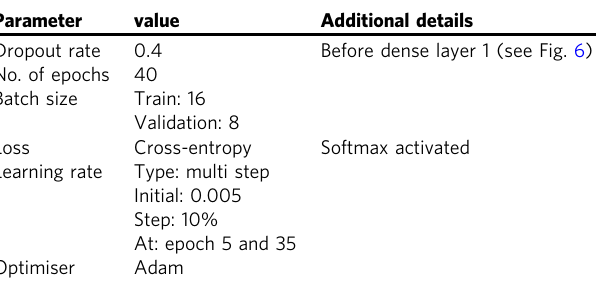
Table 2 Details on training and hyperparameters.